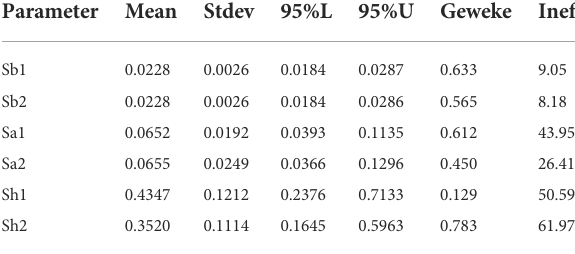
TABLE 3 Model parameter estimation results.